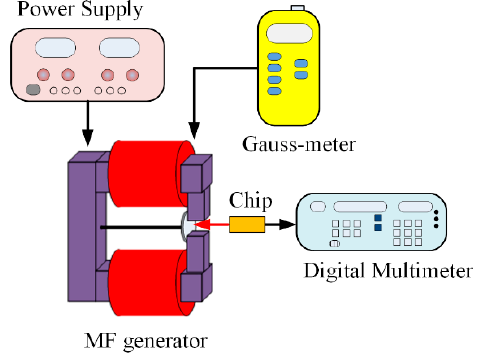
Figure 8. Experiment setup for the MMF sensor.